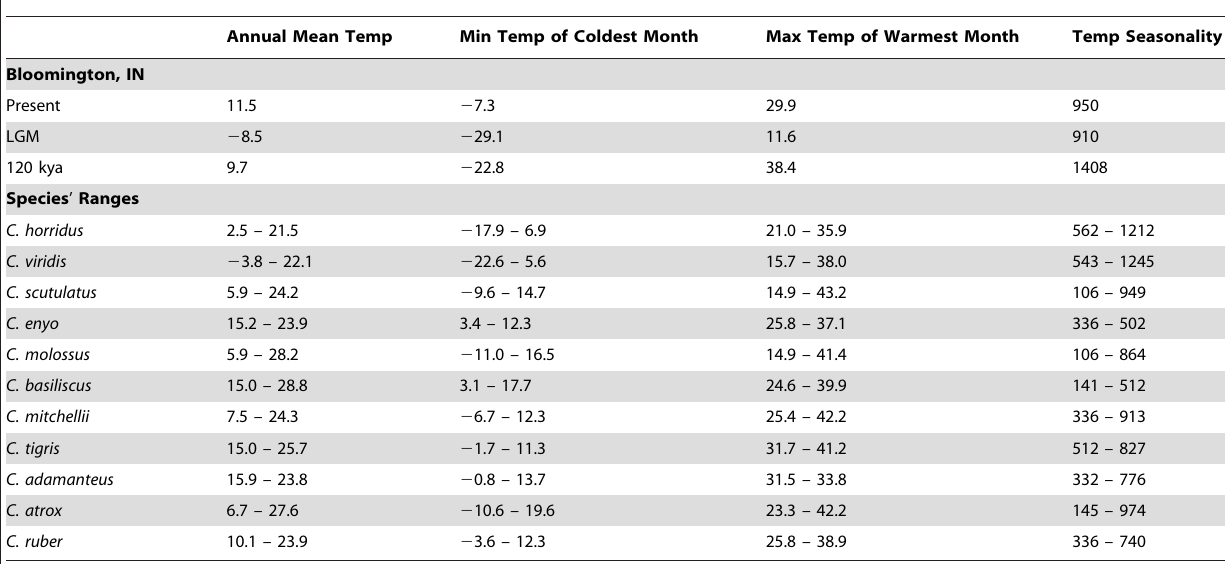
Table 3. Example of climate fluctuations for Bloomington, IN and species’